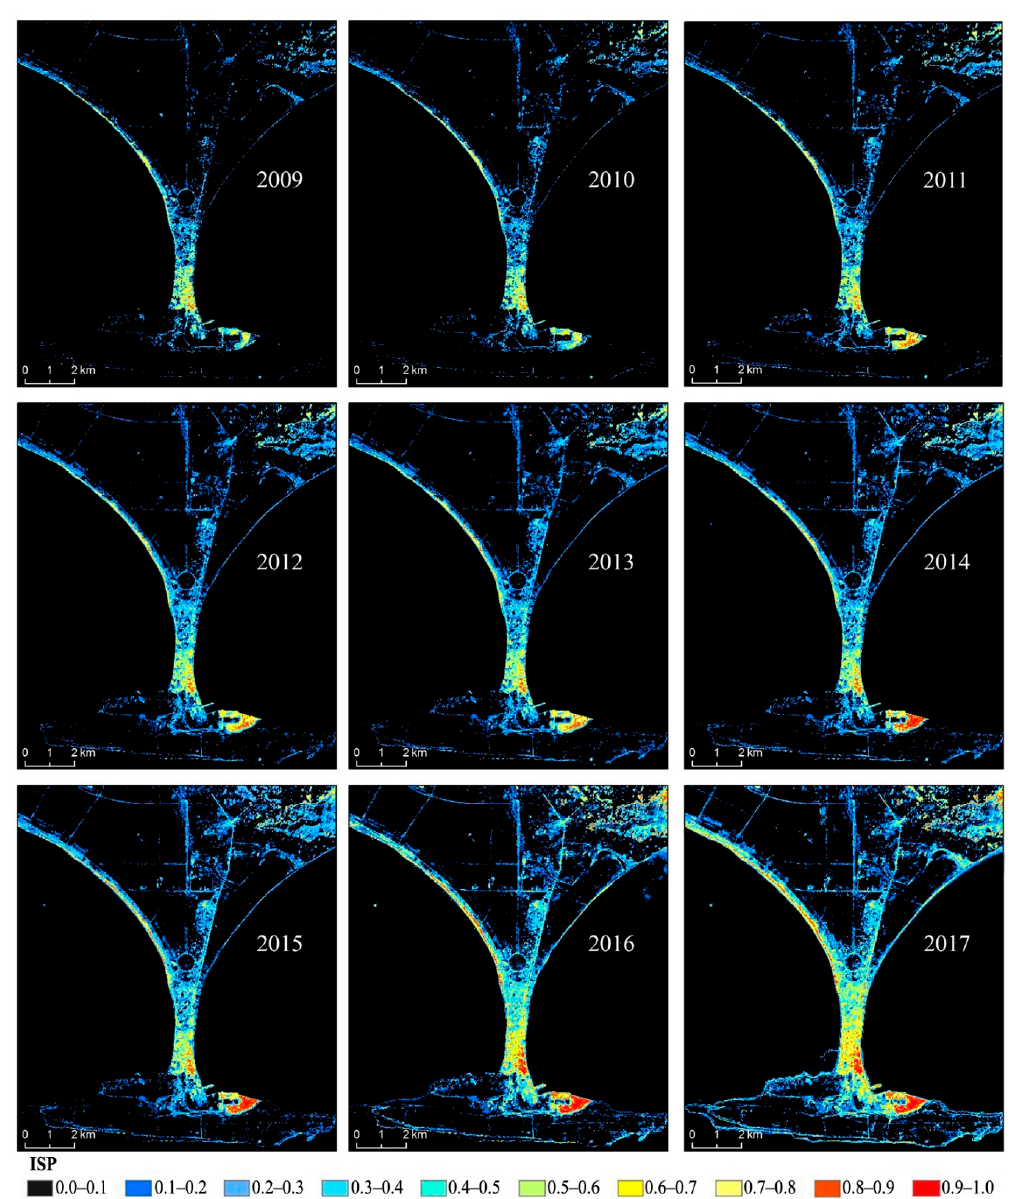
Figure 6. ISP estimation results for Gwadar city from 2009 to 2017. All the results were stretched into the same range of 0–1.